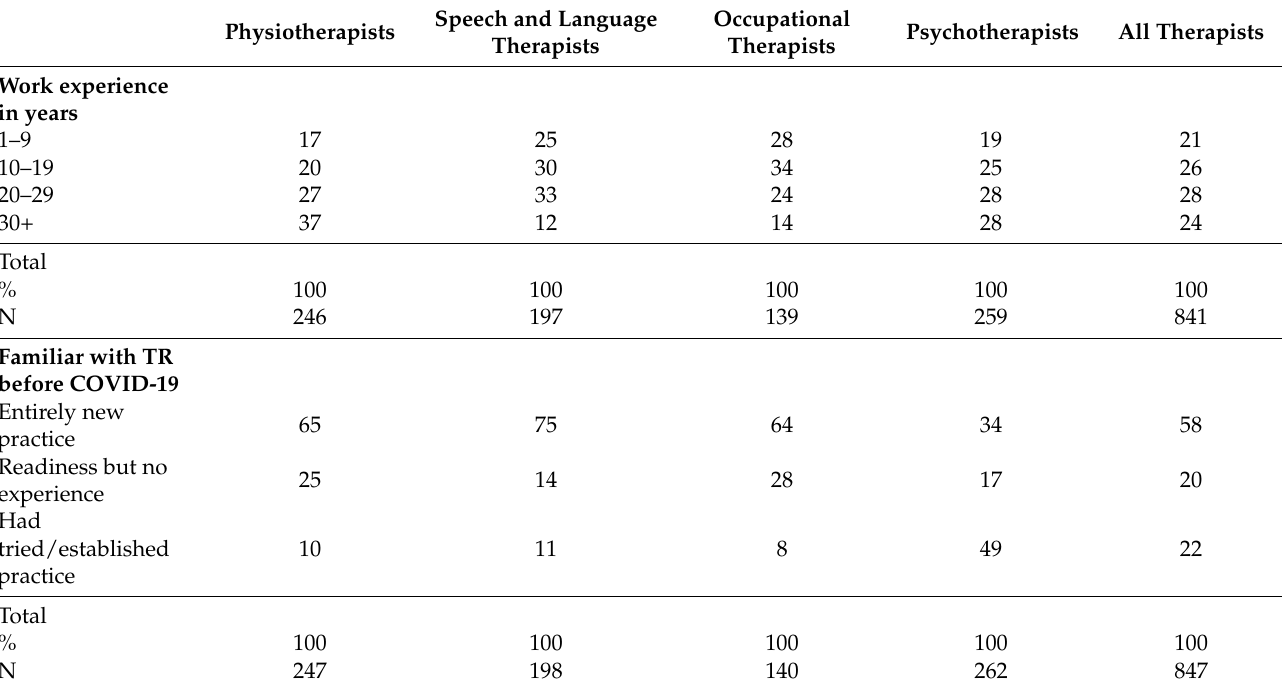
Table 1. Background variables (%) by